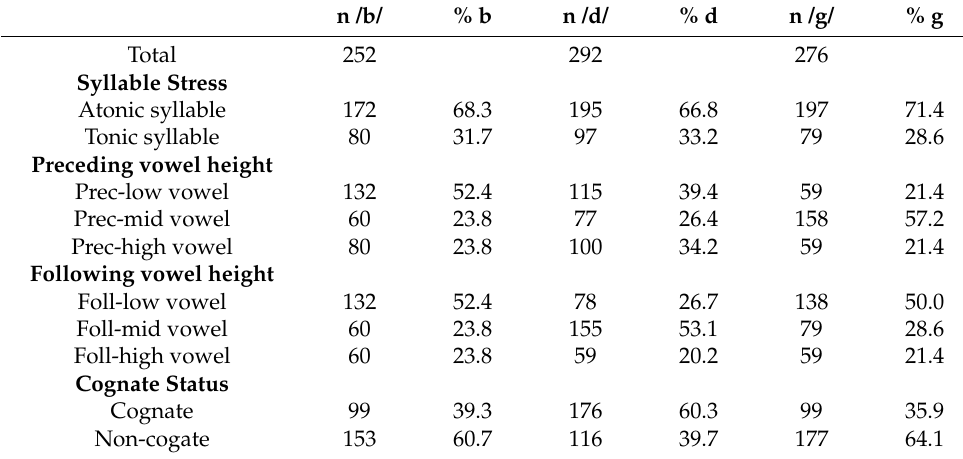
Table 1. Distribution of /bdg/ throughout word